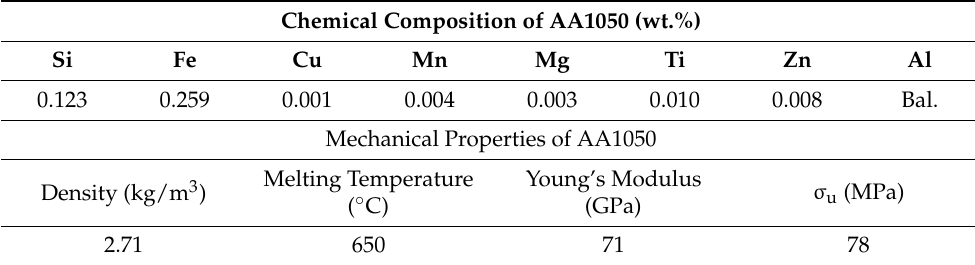
Table 1. Chemical composition and mechanical properties of